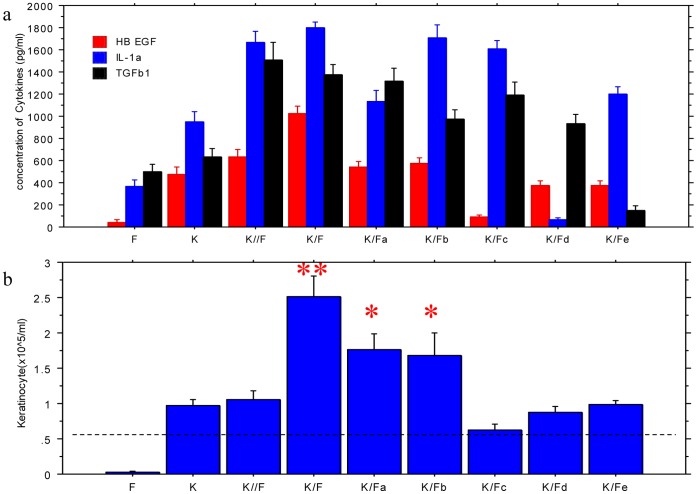
HB EGF, IL-1α and TGFβ1 levels (3a) as well as keratinocyte concentrations (3b) in different cell cultures.3×105 fibroblasts and 106 keratinocytes, respectively stained with PHK2 and PHK26, were cultured or co-cultured for 5 days. The supernatant was collected (Fig. 3a) and HB EGF, IL-1α and TGFβ1 levels were measured with ELISA. Keratinocytes (K) were harvested and resuspended in 2 ml media, and then were counted by Trypan blue exclusion and Flow Cytometry (Fig. 3b). K/F: keratinocytes were cultured with fibroblasts in common 6-well plates; K: keratinocytes alone; F: fibroblasts alone; In the co-cultures, keratinocytes were cultured with fibroblasts in transwells to separate keratinocytes and fibroblasts (K//F), with fibroblasts transfected with IL-1α siRNA (K/Fa) or TGFβ1 siRNA (K/Fb), or with fibroblasts and anti-HB EGF (K/Fc), anti-IL-1α (K/Fd) or anti-TGFβ1 (K/Fe). *P<0.05 and **P<0.01 compared to the groups without star. Four cultures in each condition. Dotted line shows the keratinocyte seeding level.